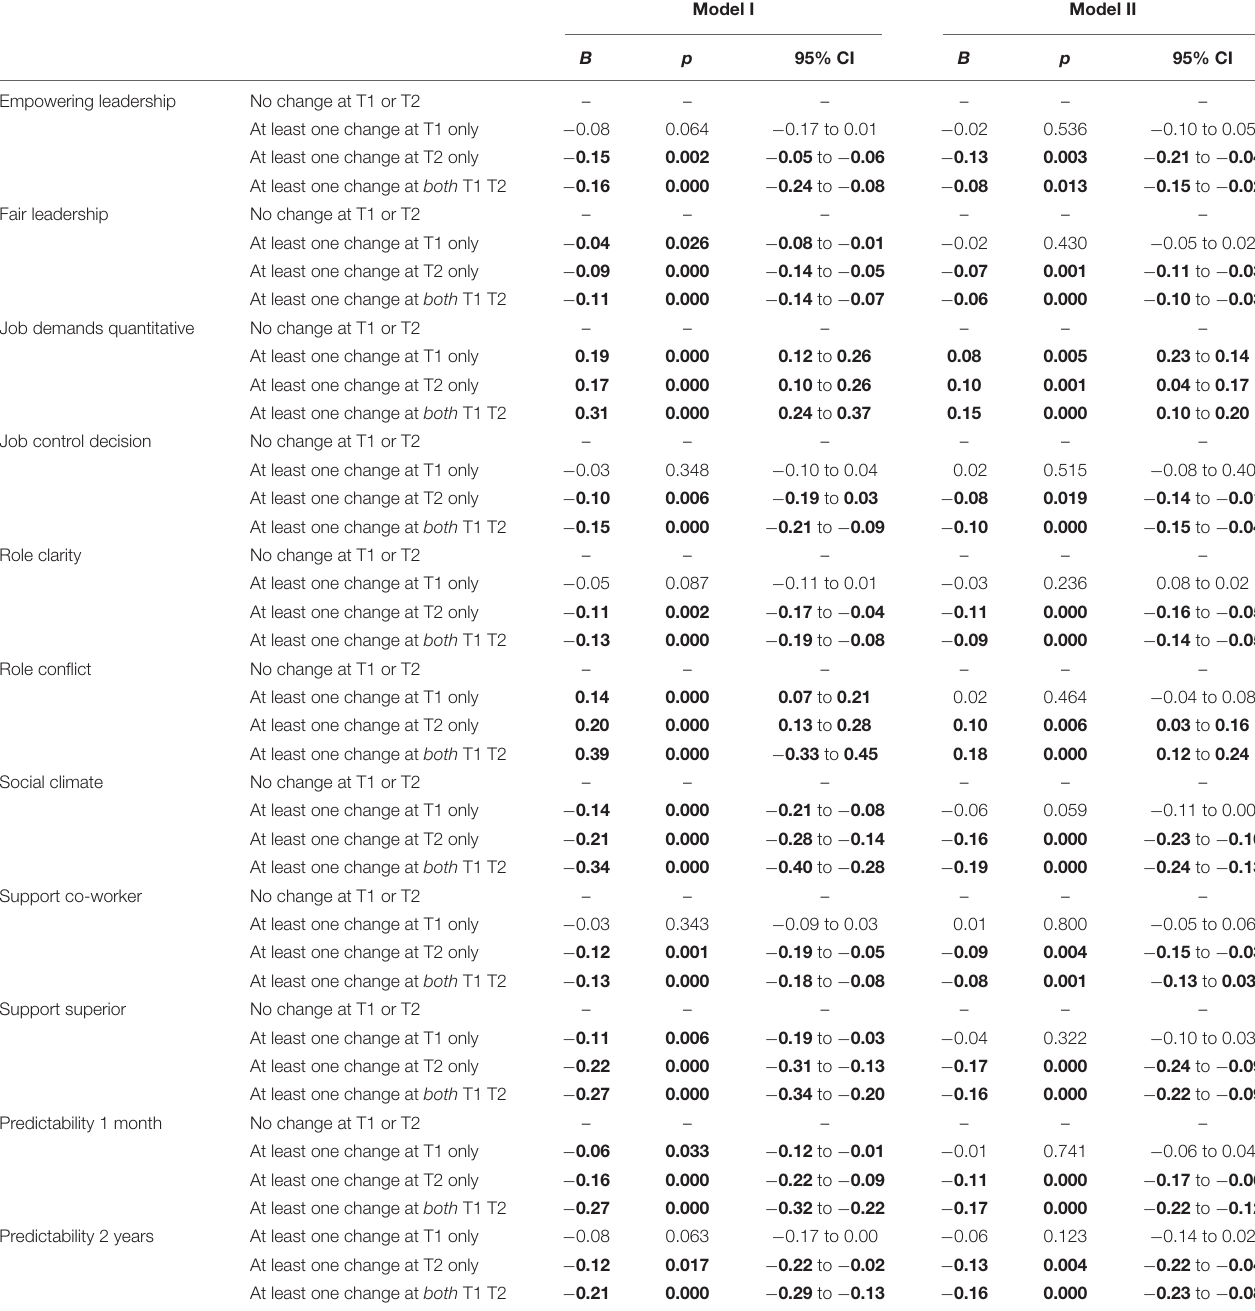
TABLE 7 | Repeated organizational